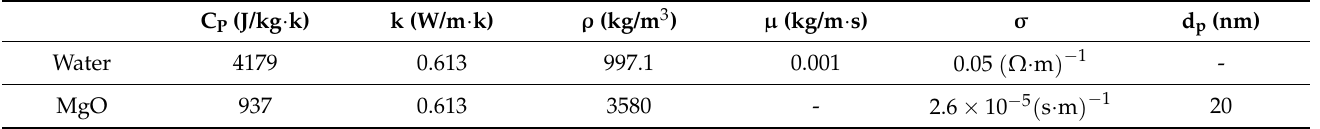
Table 1. Thermophysical properties for magnesium oxide and water NPs